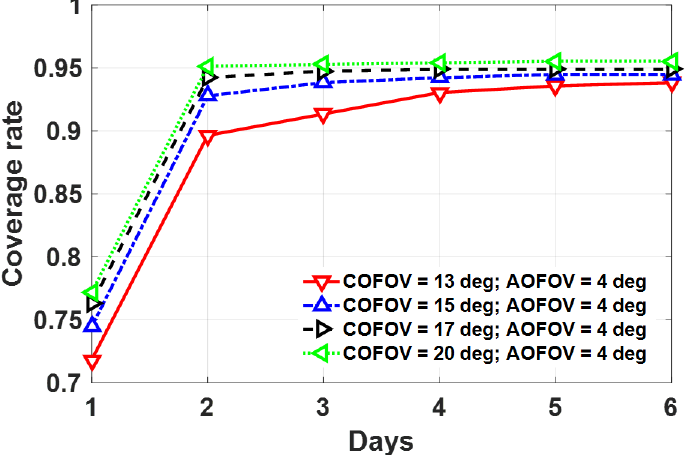
Figure 6. Sensor coverage rate with cross-orbit FOV value from 13° to 20° and along-orbit FOV value of 4°.